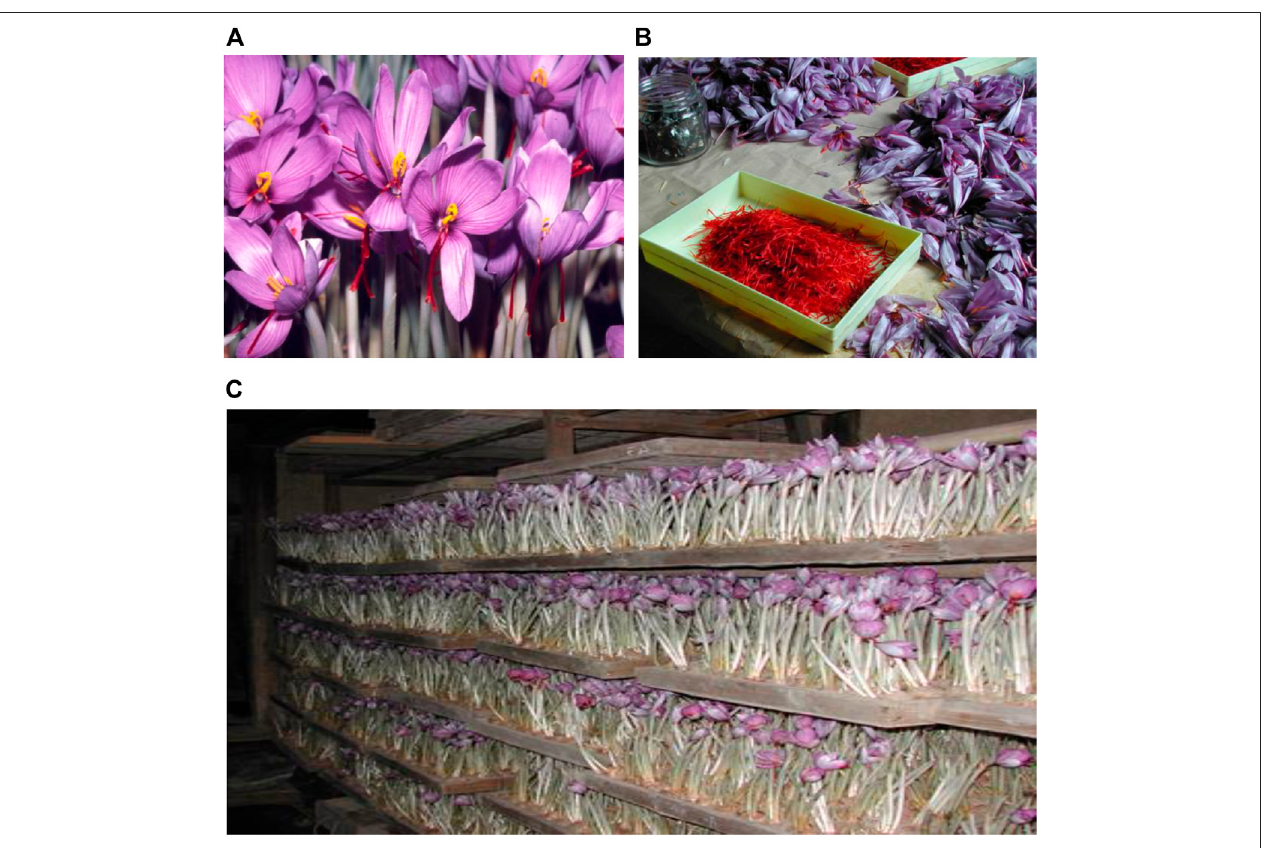
FIGURE 1 | Crocus sativus L. (A) and saffron (B) . Indoor crocus cultivation in Oita-ken, Japan (C) .